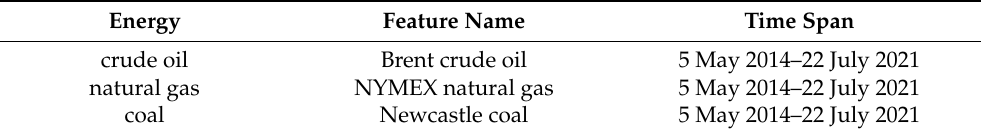
Table 2. The selection of energy prices.